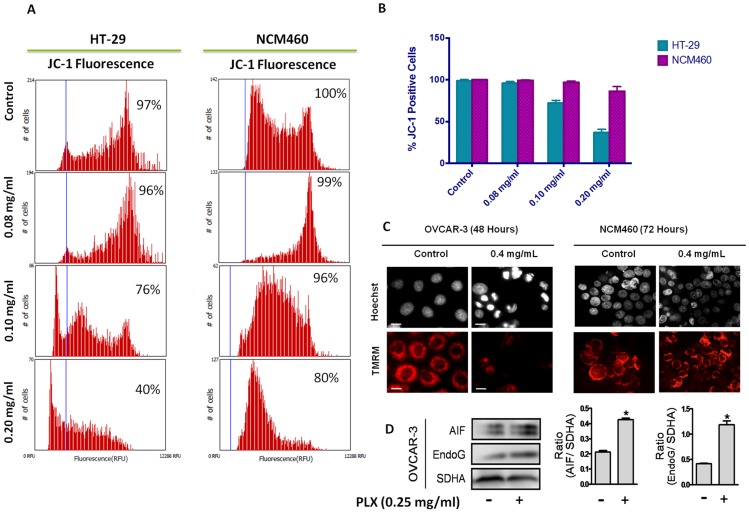
PLX Destabilizes the Mitochondrial Membrane of Cancer Cells.Colon cancer (HT-29), Ovarian cancer (OVCAR-3) and Normal Colon Epithelial (NCM460) cells were treated for 48 hours with PLX, following which, they were incubated with JC-1 (A) or TMRM (C) cationic mitochondrial membrane permeable dyes. Fluorescence readings were obtained using image based cytometry (A) and fluorescence microscopy; corresponding Hoechst dye images are also shown (C). Images were taken at 400× magnification on a fluorescent microscope. Scale bar = 15 µm. (D) Isolated mitochondria of OVCAR-3 cells were treated directly with PLX or solvent control (ethanol) for 2 hours. Following treatment, samples were centrifuged, to obtain mitochondrial supernatants, which were examined for the release of pro-apoptotic factors, AIF and EndoG via western blot analyses, and mitochondrial pellets which were probed for SDHA to serve as loading controls. Image is representative of 3 independent experiments demonstrating similar trends. Values are expressed as mean ± SD of quadruplicates of 1 independent experiment; *p<0.01 versus solvent control (ethanol).